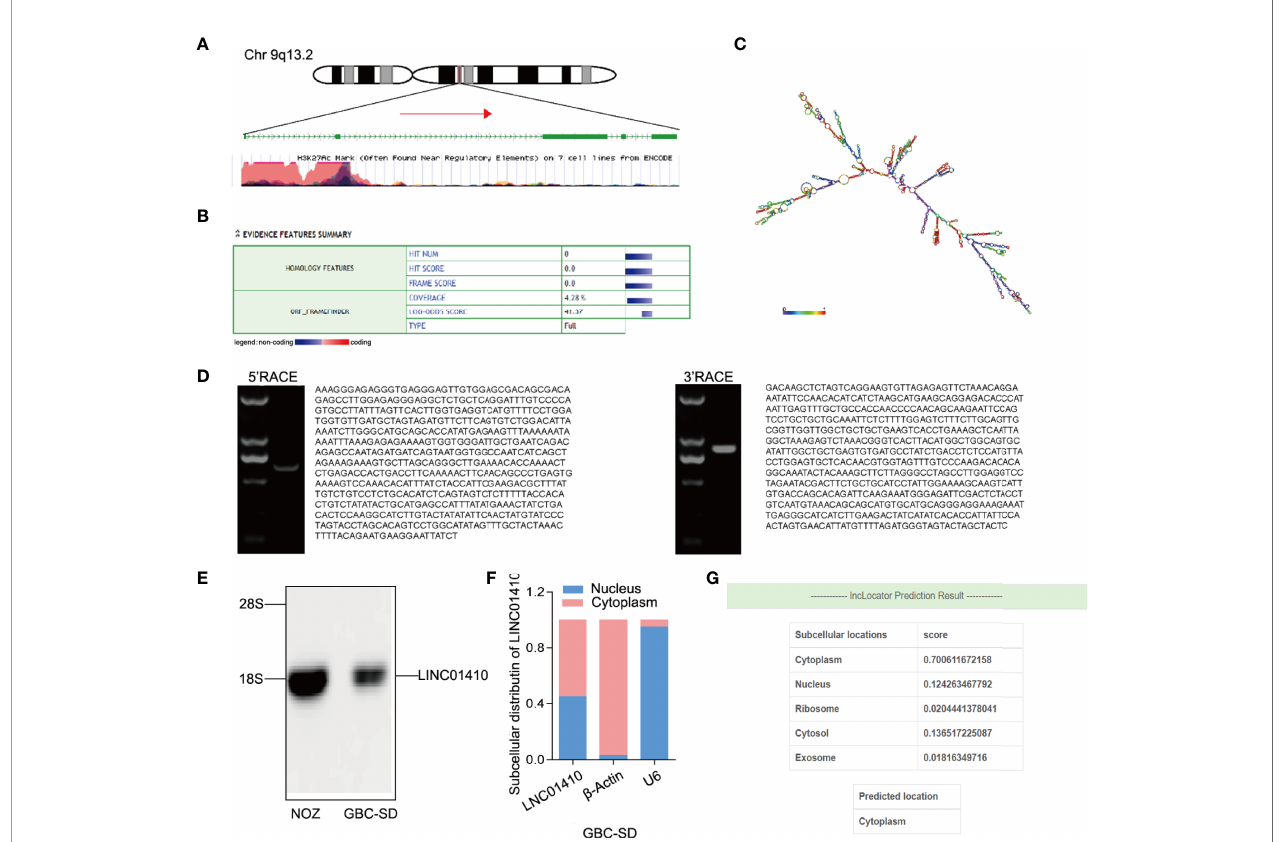
FIGURE 3 | Basic characterization of LINC01410. (A) Schematic diagram of LINC01410. (B, C) ORF fi nder (B) and secondary structure (C) prediction for protein-coding potential of LINC01410. (D) Gel electrophoresis of nested PCR products from 5 ′ -RACE and 3 ′ -RACE. (E) Western blot analysis of LINC01410 transcripts in NOZ and GBC- SD cell lines. (F) Subcellular localization of LINC01410 in GBC cells using cell fractionation assays. (G) The location of URRCC predicted by